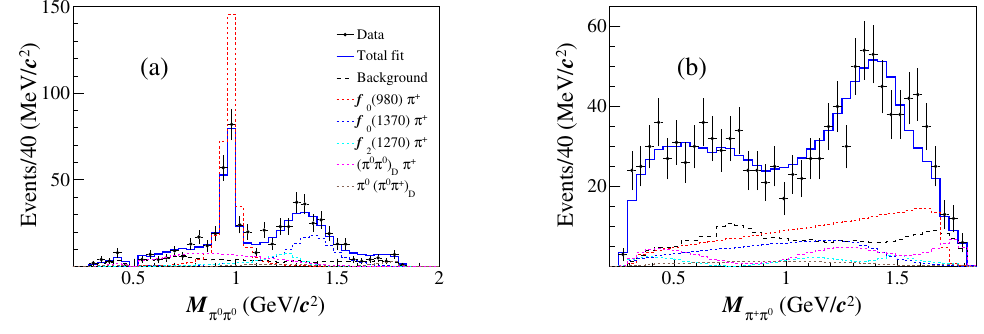
Figure 3 . The projections of (a) M and (b) M from the nominal fit. Two M are π 0 π 0 π + π 0 π + π 0 calculated and added due to the indistinguishable π 0 ’s. The data samples are represented by points with error bars, the fit results by the solid blue lines, and the background estimated from inclusive MC samples by the black dashed lines. Colored dashed lines show the components of the fit model. Due to interference effects, the total is not necessarily equal to the sum of the